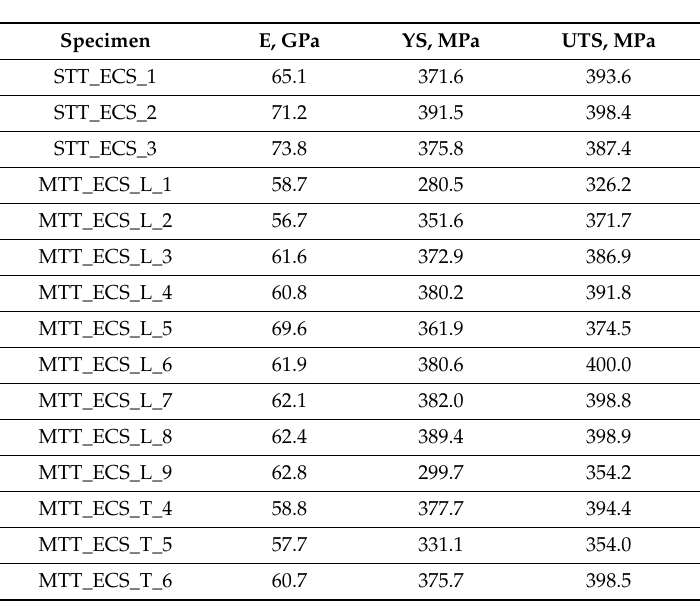
Table A4. Tensile test results for ECS